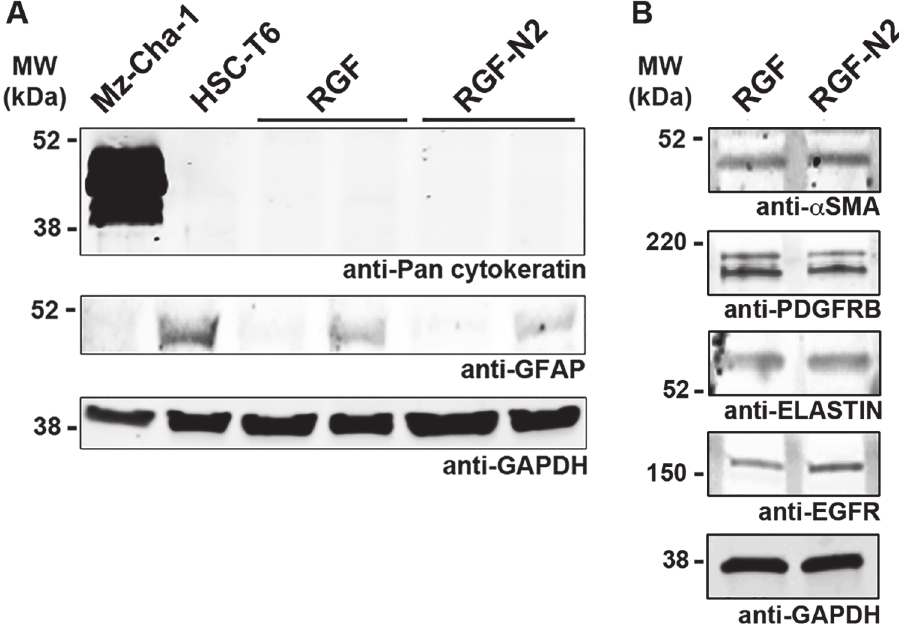
Fig 2. Phenotypic characterization of immortalized rat portal fibroblastic RGF and RGF-N2 cell lines by immunoblot. (A) Immortalized rat PF RGF and RGF-N2 protein samples were analyzed for expression of Gfap and cytokeratins. Housekeeping Gapdh protein was used as loading control, Mz-Cha-1 cell lysate as positive control for cytokeratin expression, and HSC-T6 cell lysate as positive control for Gfap expression. RGF (passage #59, 1 st lane and passage #34, 2 nd lane) and RGF-N2 (passage #52, 1 st lane and passage #25, 2 nd lane) cells do express neither cytokeratin proteins nor Gfap protein (after 45 passages for the latter). (B) Immortalized rat PF RGF and RGF-N2 protein samples were analyzed for expression of α SMA, Elastin, Pdgfr β and Egfr. RGF and RGF-N2 express all proteins tested. Housekeeping Gapdh protein was used as loading control. kDa , kiloDaltons